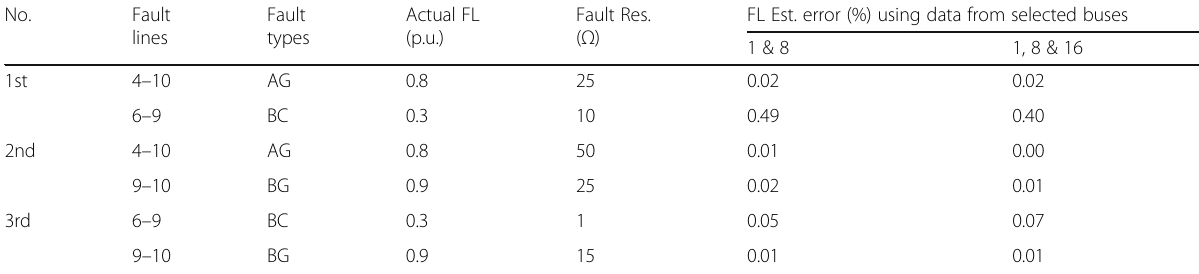
Table 7 Fault location results for multiple simultaneous faults on transposed lines